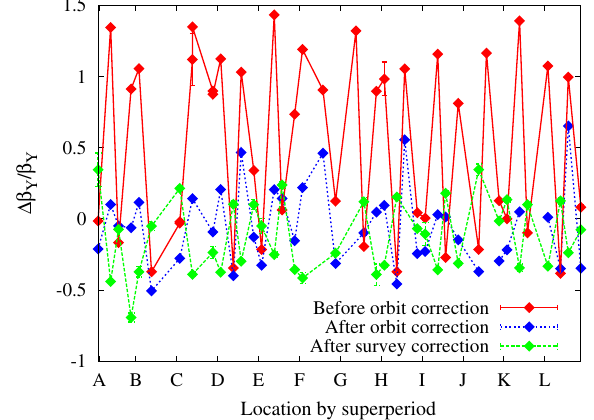
FIG. 2. The measured vertical beta function beat ( d β y = β y ) in the AGS. Zero reading means no beta beat. The beta beat is significantly reduced after the 6 θ horizontal orbit correction or magnet realignment.